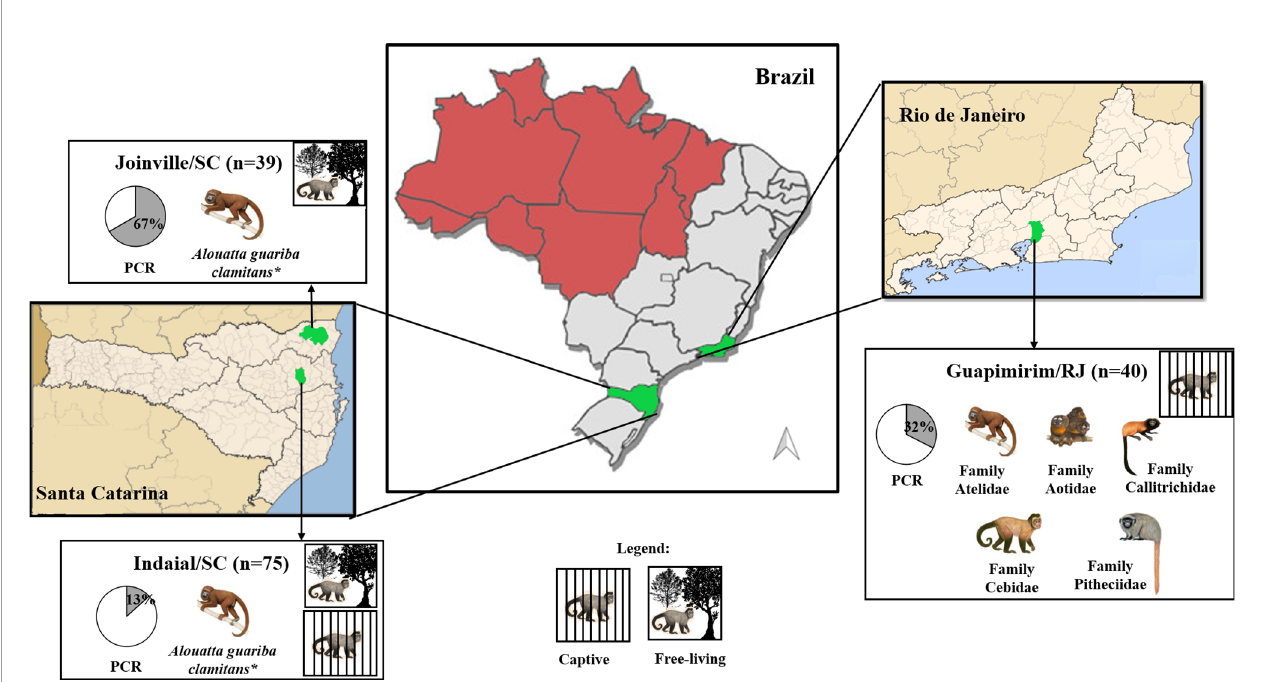
FIGURE 1 | Geographical distribution of the three studied areas and characteristics of studied neotropical primates. Captive or free-living monkey pictures represent species/families of NP from each studied area. The pie graph represents the proportion (%) of positivity (gray) for Plasmodium by PCR (Snounou et al., 1993; de Alvarenga et al., 2018). Malaria endemic areas (red) and study areas (green). * Alouatta guariba clamitans is the only species